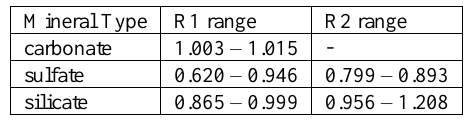
Table 1. Ranges of spectral indices from mineral in ASU